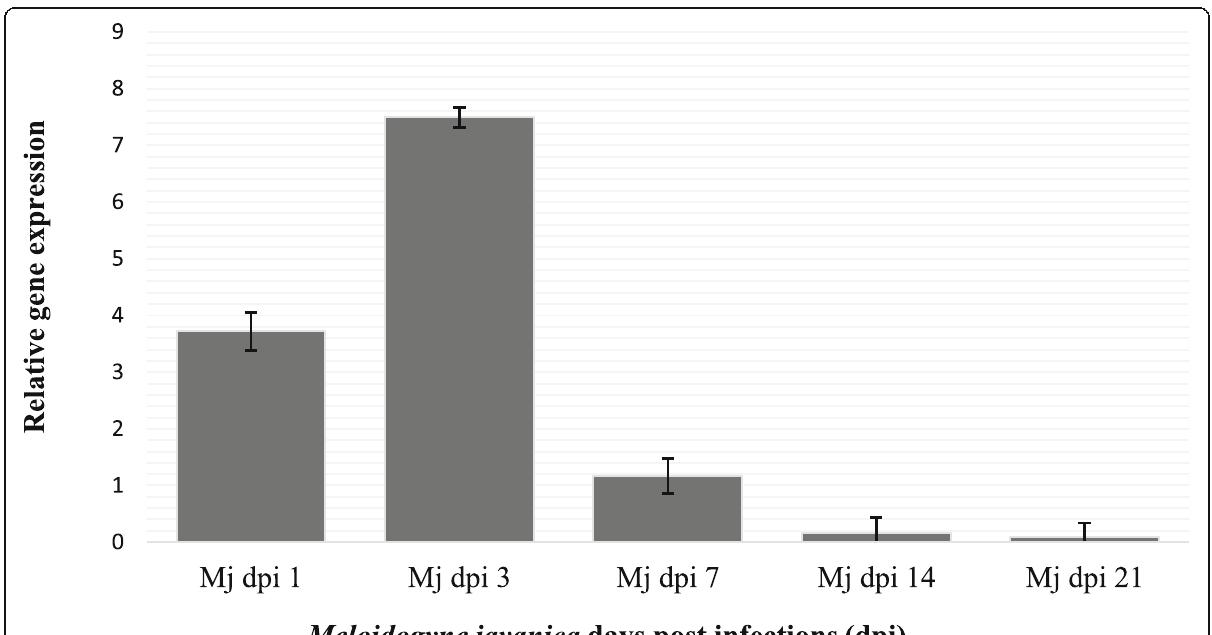
Fig. 3 Meloidogyne javanica induced proteinase inhibitor I gene expression in host tissues at different days post infections. Housekeeping gene actin gene was used to normalize expression of genes of interest. Relative gene expression was calculated biological replicates using the 2 △△ Ct method and uninfected (control) values were subtracted from infected values. Y axis represents relative gene expressions, X axis indicates 1 dpi, 3 dpi, 7 dpi, 14 dpi, 21 dpi following Meloidogyne javanica infection. Error bars represents the standard error of the means of three replicates. Mj, Meloidogyne javanica ; dpi, days post